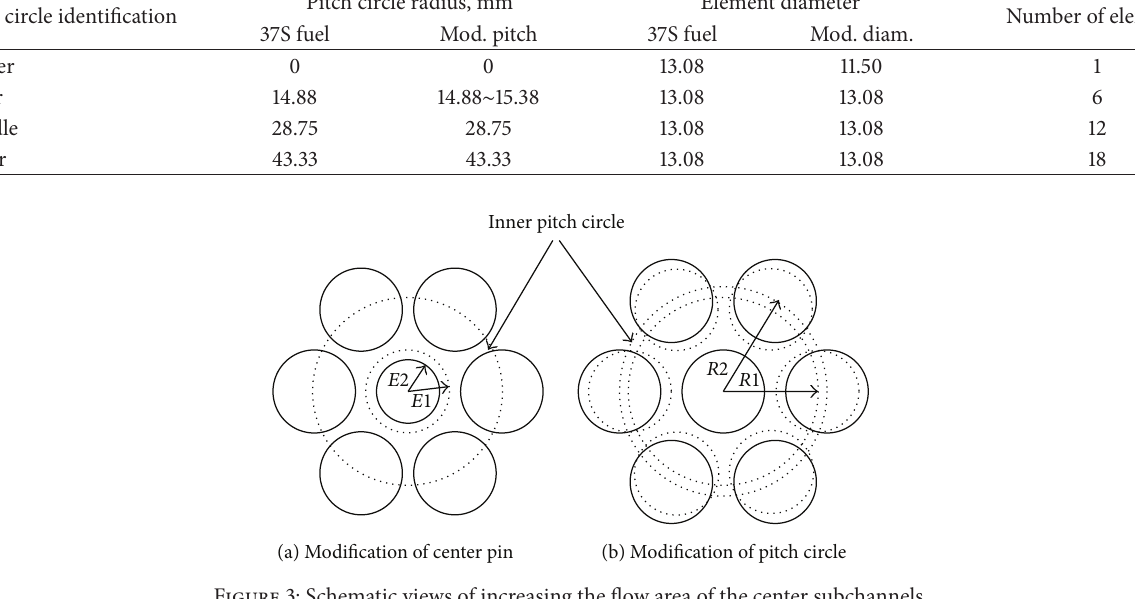
Figure 3: Schematic views of increasing the flow area of the center subchannels.